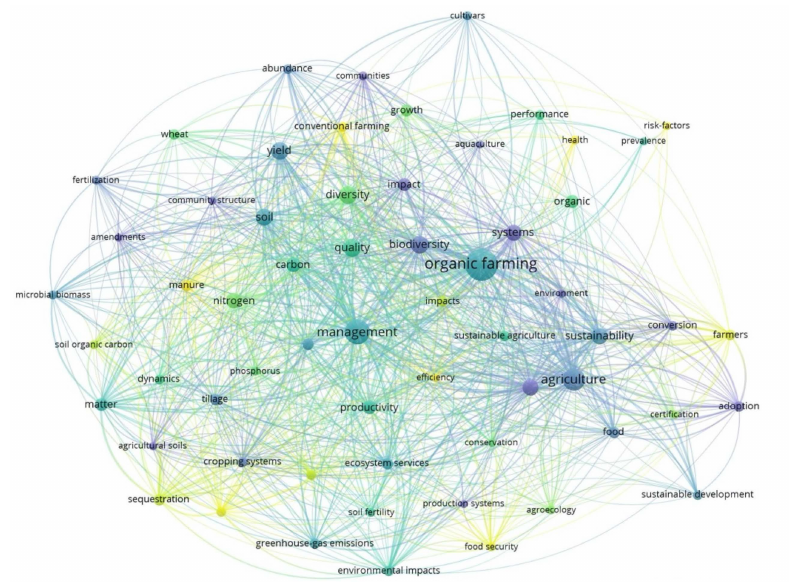
Figure 3. The bibliometric keywords analysis of organic farming dimension, considering Web of Science (WOS) publications during the years 2017–2022. Source: Elaborated by the authors using VOSviewer